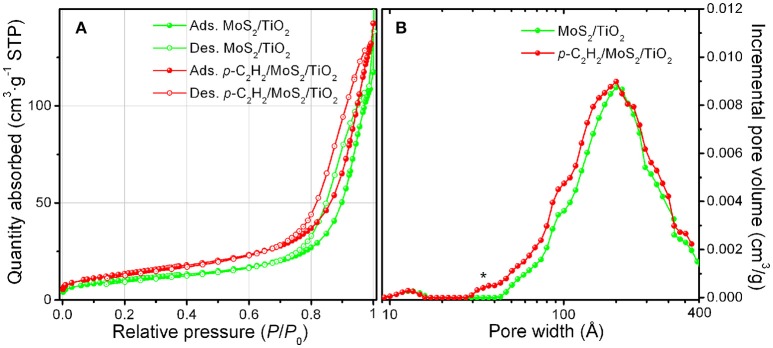
N2-absorption/desorption isotherms (A) and pore size distribution (B) of MoS2/TiO2 sample (green curves) and p-C2H2/MoS2/TiO2 as obtained after C2H2 treatment. The asterisk in (B) highlights a weak additional contribution of small pores, 30–40 Å in size, for p-C2H2/MoS2/TiO2 (red curve).